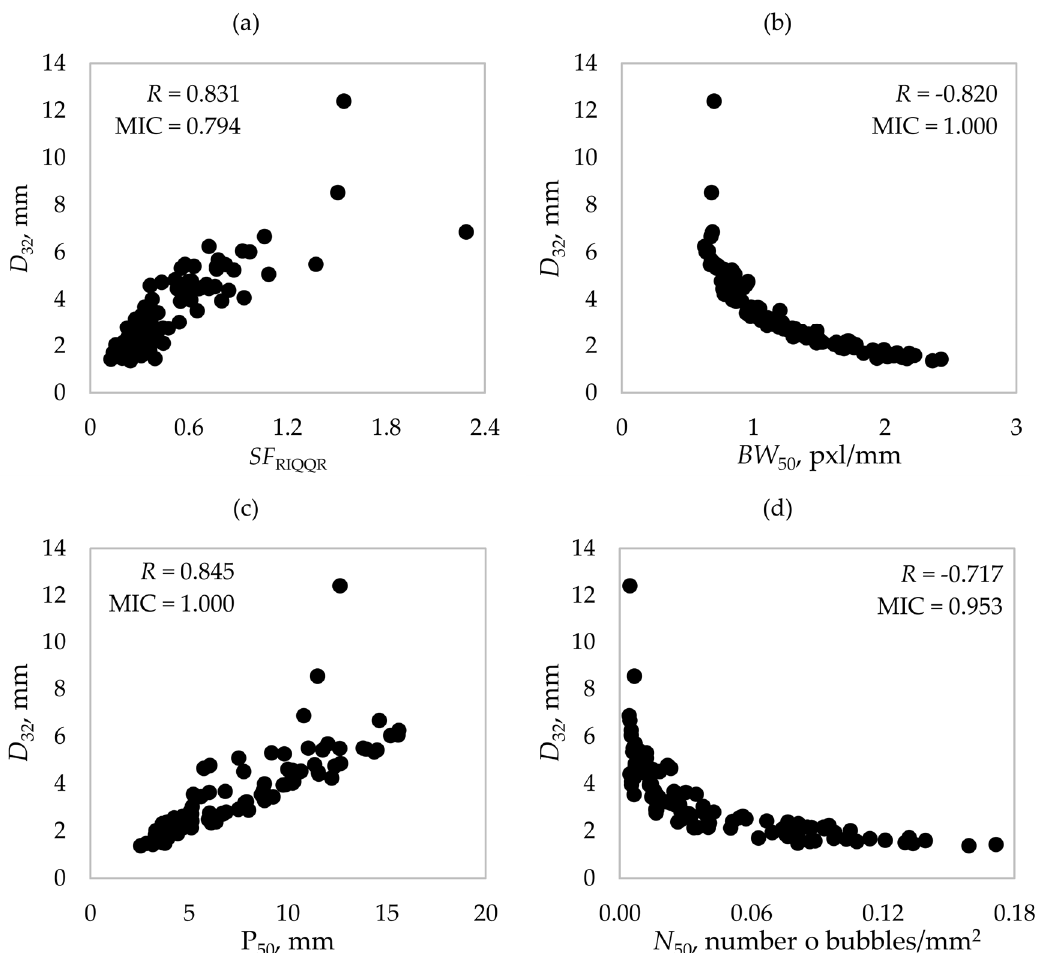
Figure 3. Correlation between different object/image properties and the Sauter diameter: ( a ) D 32 ver-